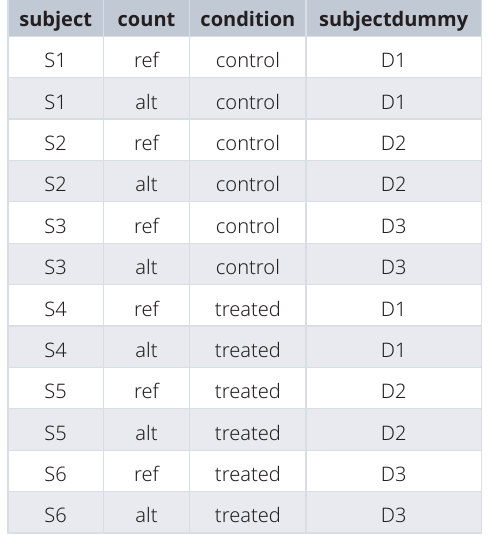
Table 1. Sample data table for the allele-specific differential expression use